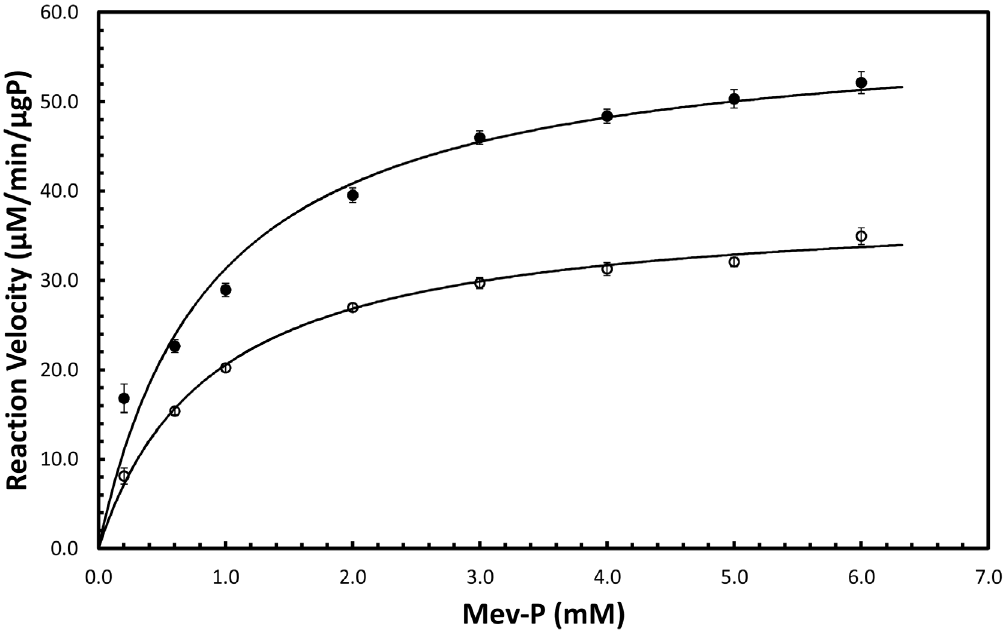
Figure 4. Initial reaction velocity as a function of mevalonate-5-phosphate concentration. Closed circles are data for incubation at 37 u C and open circles are data for incubation at 30 u